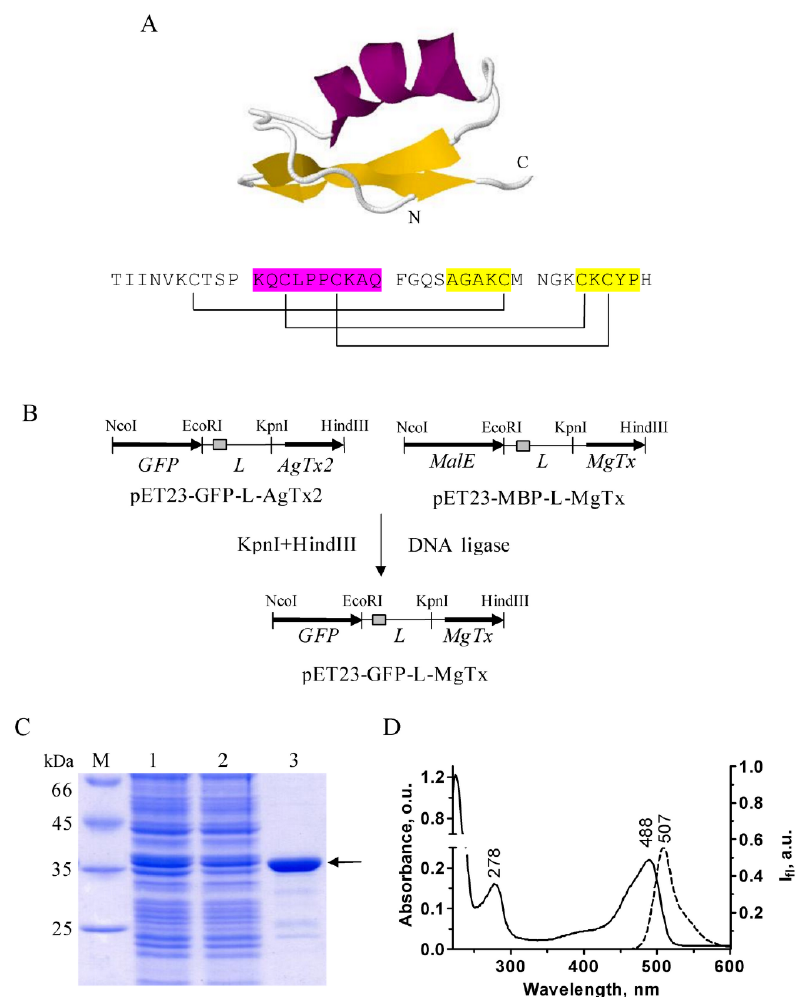
Figure 1. Production and purification of GFP–MgTx. ( A ) 3D structure (PDB ID: 1MTX) and amino acid sequence of MgTx. α -Helix is shown in magenta, β -sheet—in yellow. The pattern of disulfide bond formation is shown with brackets. ( B ) Construction of expression cassette in the plasmid pET23-GFP-L-MgTx. His6 tag is shown as a grey rectangle. MalE —a gene encoding maltose binding protein (MBP). L is a linker, which connects a protein tag (MBP or GFP) with the toxin moiety. ( C ) Coomassie-stained 12.0% SDS-PAGE gel that shows the level of total GFP–MgTx biosynthesis in E. coli Rosetta-gami B(DE3)pLys (lane 1), cellular lysate after sonication and after subsequent centrifugation (lane 2), and a purified GFP–MgTx after Ni-affinity chromatography (lane 3). M is a protein mass marker. Position of the target protein is shown by an arrow. ( D ) Absorption (solid line) and fluorescence (dashed line) spectra of GFP–MgTx in phosphate-buffered saline. O.u.—optical units.